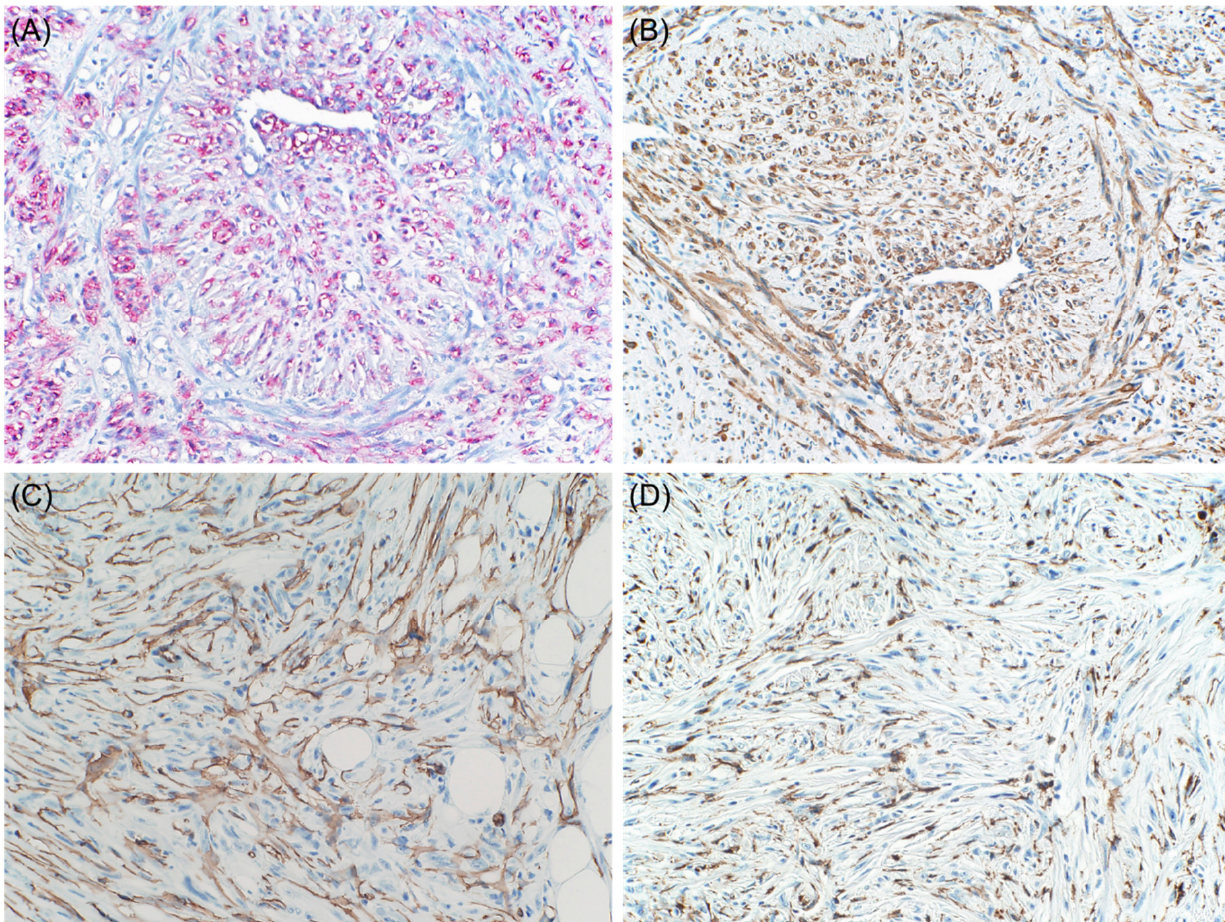
Figure 3. Desmoplastic and neurotropic melanoma. Lesional cells are positive for NGFR ( A , immunohistochemical stain 20) with aberrant expression of actin ( B , immunohistochemical stain 20), CD34 ( C , immunohistochemical stain 20), and CD68 ( D , immunohistochemical stain 20).